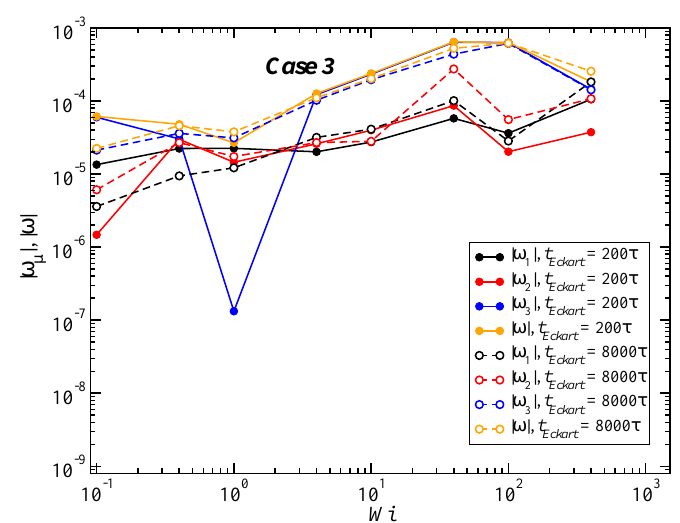
Figure A1. Values of the average magnitudes of the components of the angular velocity, | ω µ | , and the magnitude of the whole vector, | ω | , for Case 1 as a function of Wi for two different values of t Eckart as indicated in the legend, for Cases 1, 2 and